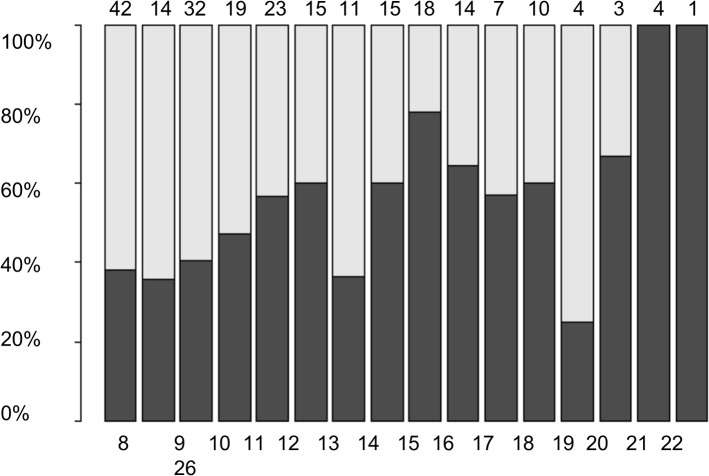
Relative frequency (in percent) of good (black) and bad (white) sleepers in each group of patients with the same number of years of education.The number of patients is shown above the bars and the number of years of education is shown below the bars.